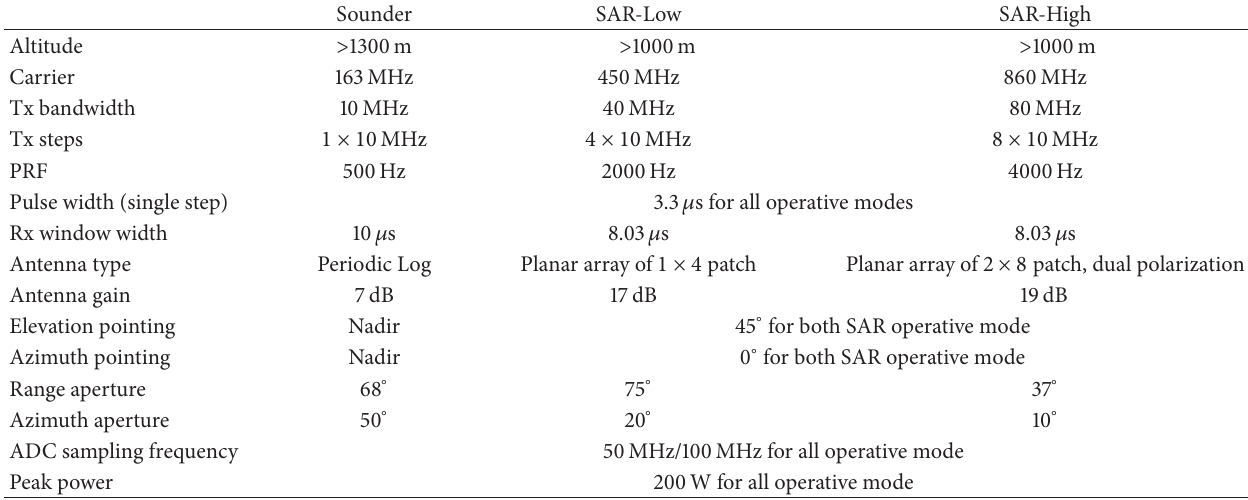
Table 2: System parameters.